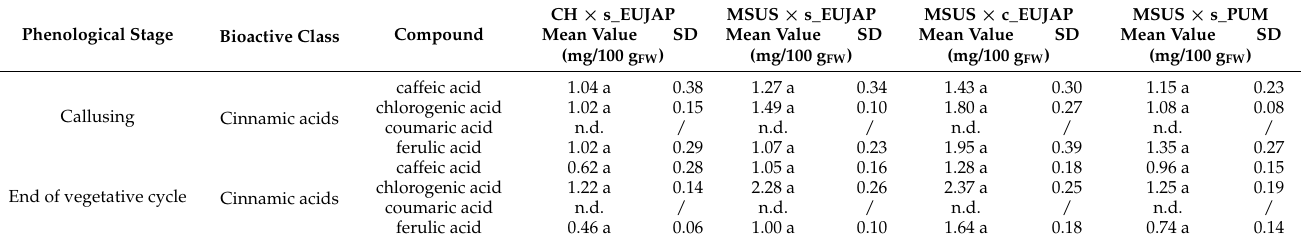
Table 3. Cinnamic acid fingerprint of the tissues at the graft union. The results are reported as mg of the bioactive compound per 100 g fresh weight